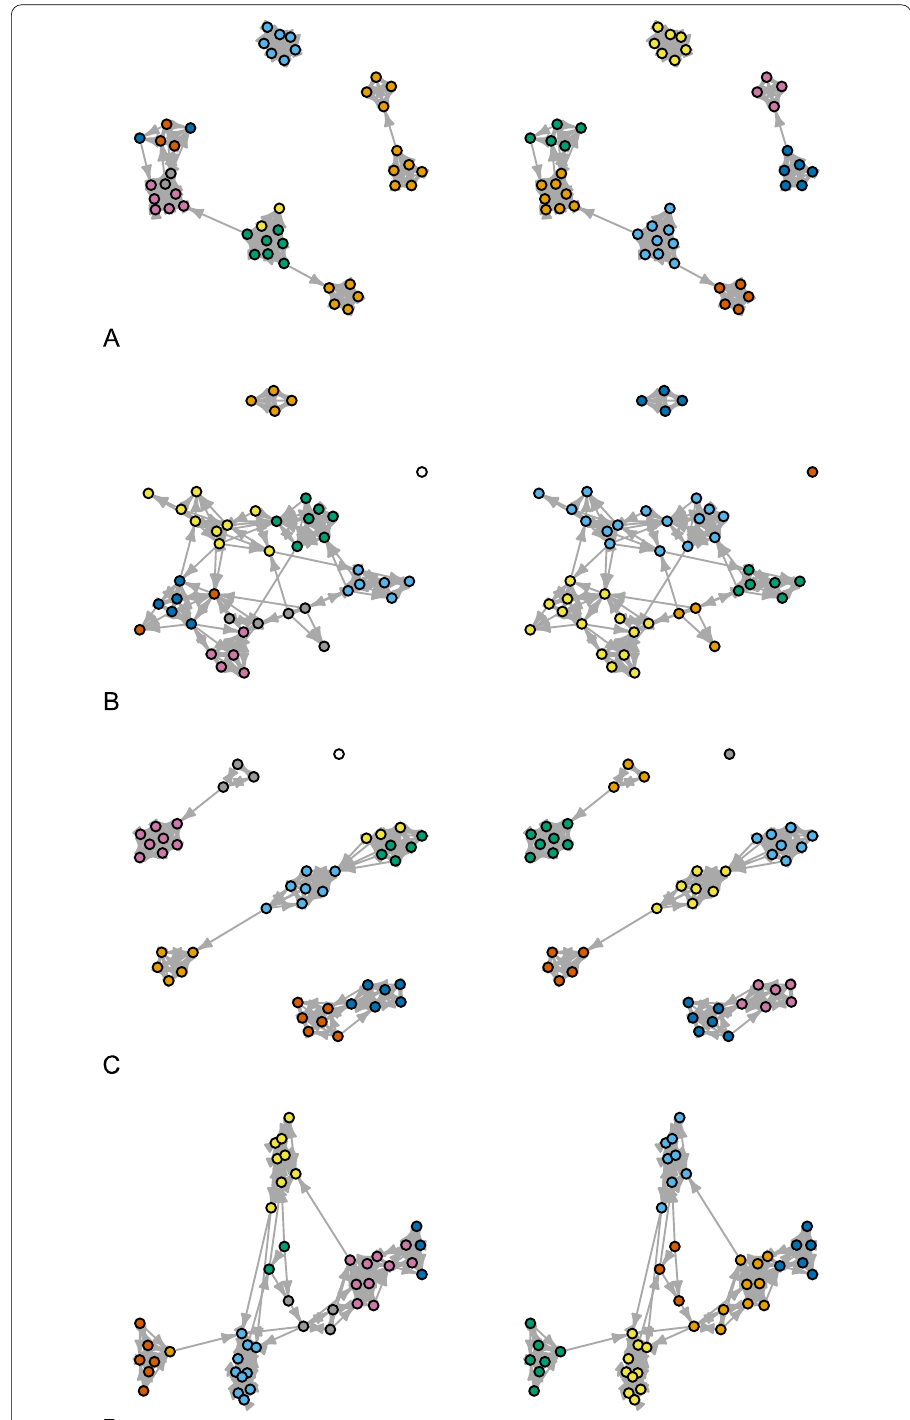
Fig. 11 Fall 2015 sociograms for exams 1–4 in each row labeled A–D respectively. In the left column, node color is given by the CONCOR algorithm, while on the right, node color is given by the edge-betweenness